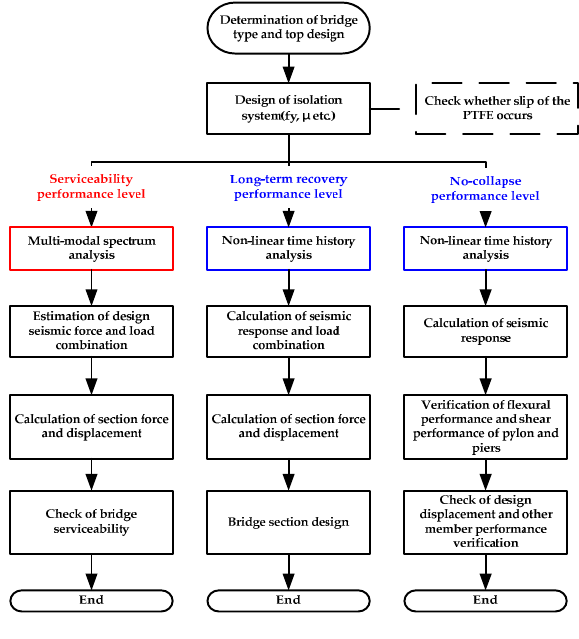
Figure A2. Proposed design procedure for R-FBI (Case II).